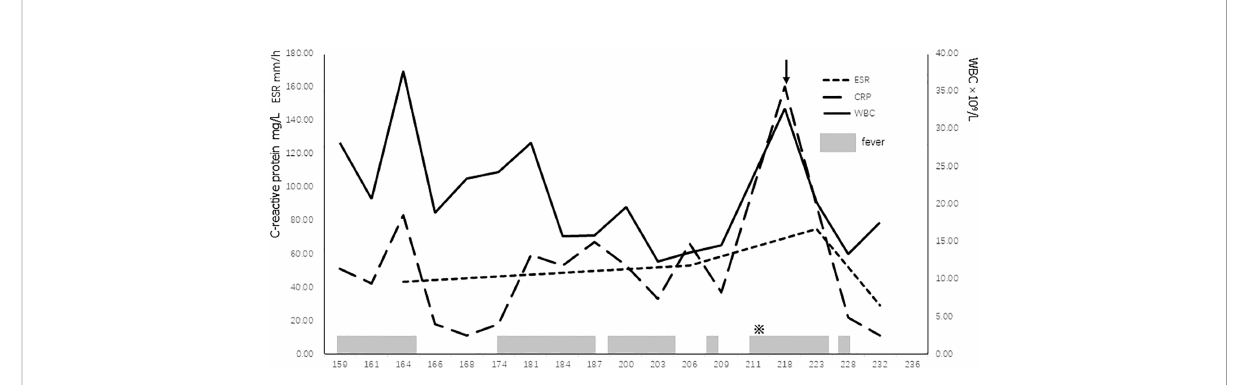
FIGURE 1 Trajectory of patient ’ s WBC and in fl ammatory markers with clinical events. ※ , more subcutaneous nodules; arrow, administration of methylprednisolone; ESR, erythrocyte sedimentation rate; WBC, white blood